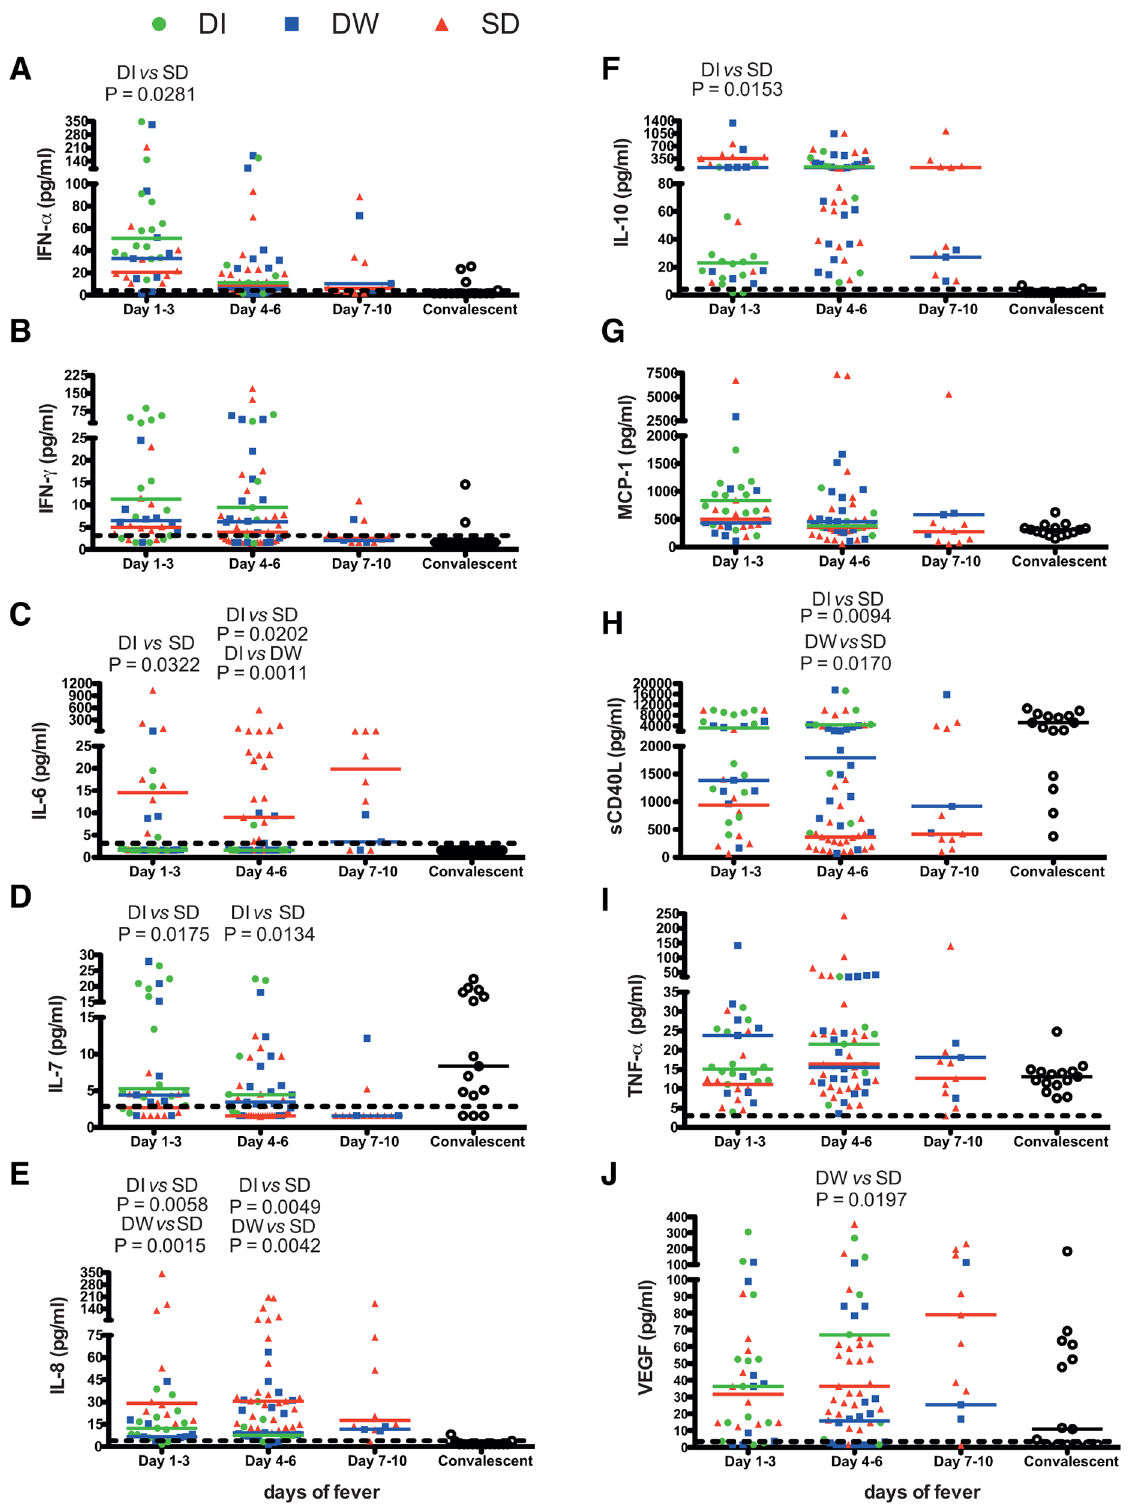
Fig 4. Cytokine profile in dengue patients on indicated days of fever and disease severity. Plasma levels of cytokines/chemokines/inflammatory mediators in dengue patients were measured by multiplex magnetic bead assays. (A) IFN- α (B) IFN- γ (C) IL-6, (D) IL-7, (E) IL-8, (F) IL-10 (G) MCP-1 (H) sCD40L, (I) TNF- α and (J) VEGF. Data are segregated into days of fever and disease severities within each group. Median value of cytokines in